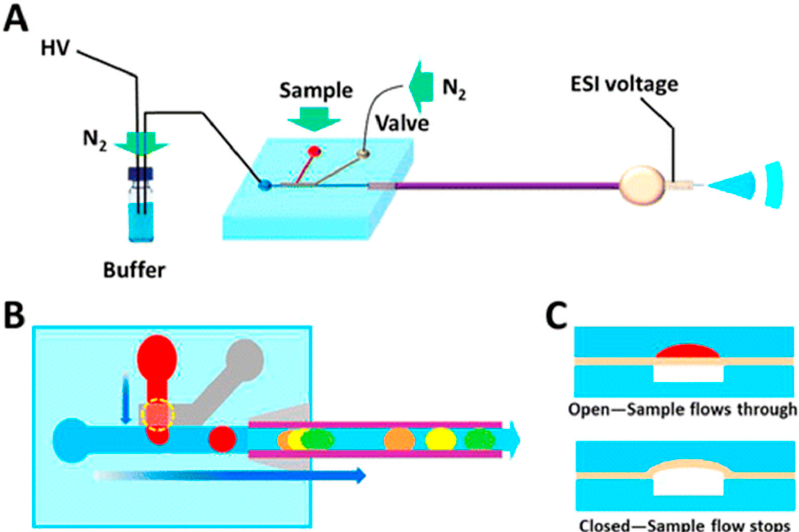
Figure 3. Schematic of hybrid microchip-CE setup for highly controlled, reproducible sample injections through the use of a hydrodynamic pneumatic-microvalve apparatus ( A ). Sample injection and electrophoretic separation was performed via switching of the valve ( B ). Channels of flow (red) and control (white) were separated by a membrane in both open and closed states ( C ). Reprinted with permission from https://pubs.acs.org/doi/abs/10.1021/ac501910p [14]. Adapted with permission from the American Chemical Society.